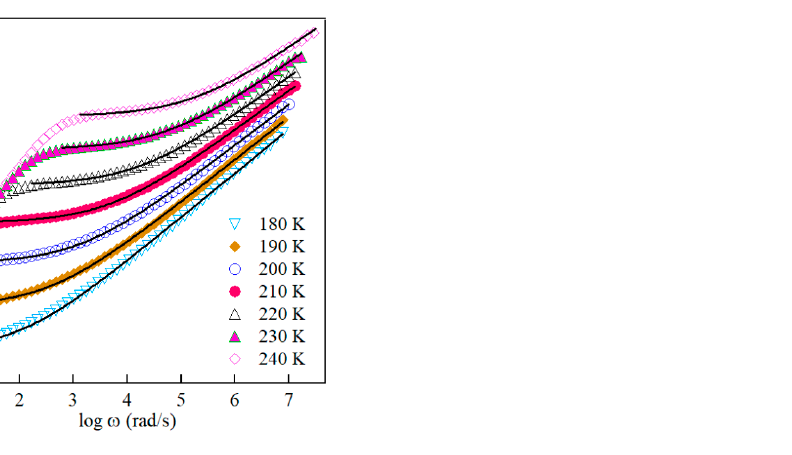
Figure 5. The conductivity spectra of LLT-Ga garnets with x = 0.30 at different temperatures. The solid curves between the points represent the best fits to Equation (2).